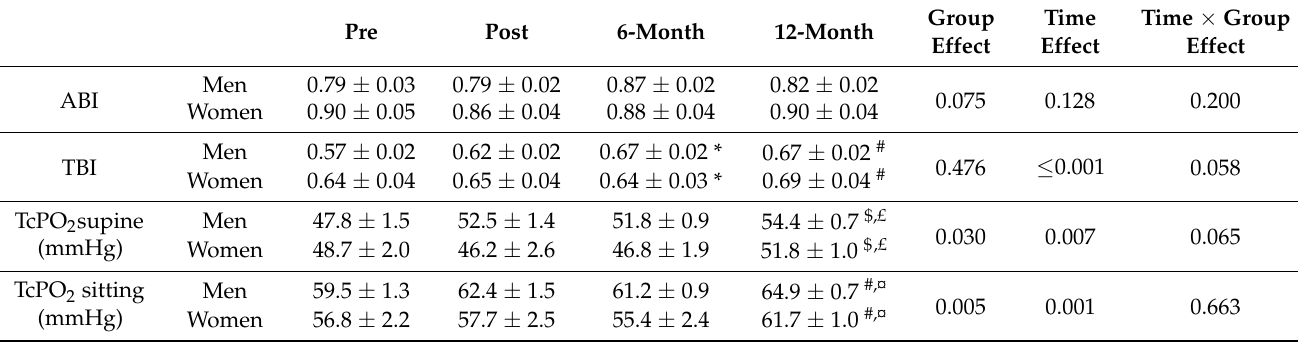
Values are the means ± SE. ABI—ankle-brachial index; TBI—toe-brachial index; TcPO 2 —transcutaneous oxygen pressure. * p = 0.028 for significant difference compared to pre-SET condition (multiple comparisons with Bonferroni adjustment). # p = 0.002 for